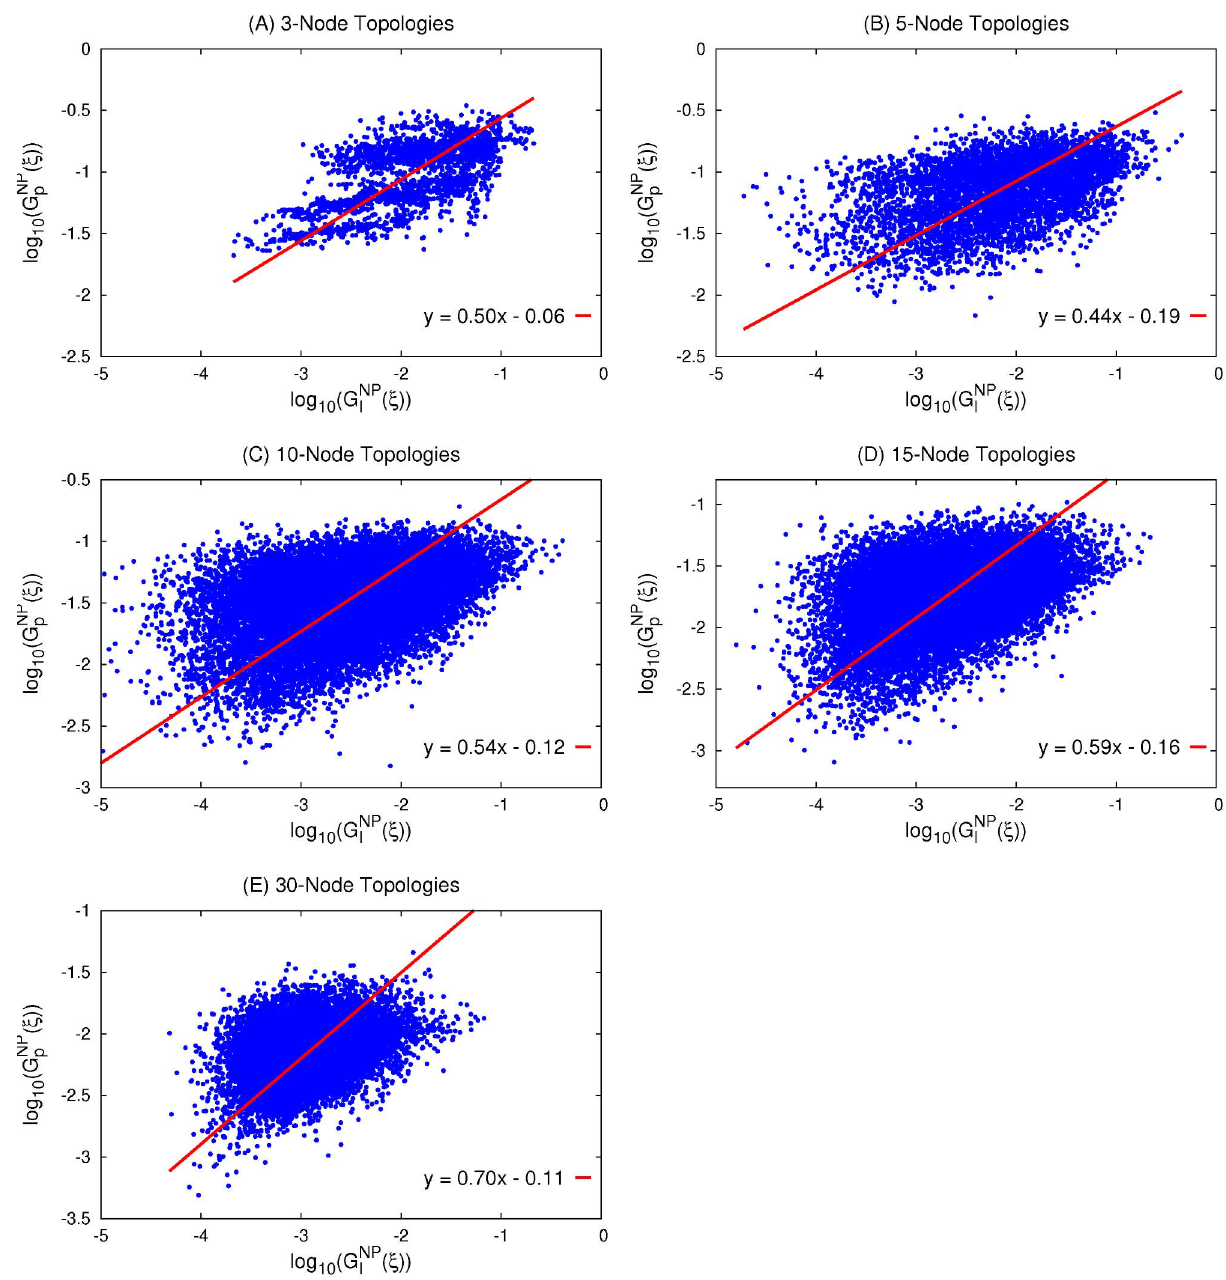
Figure 4. Correlation between robustness to input and parameter perturbations within 3-node, 5-node, 15-node, and 30-node NP j ð Þ networks. log 10 G NP I